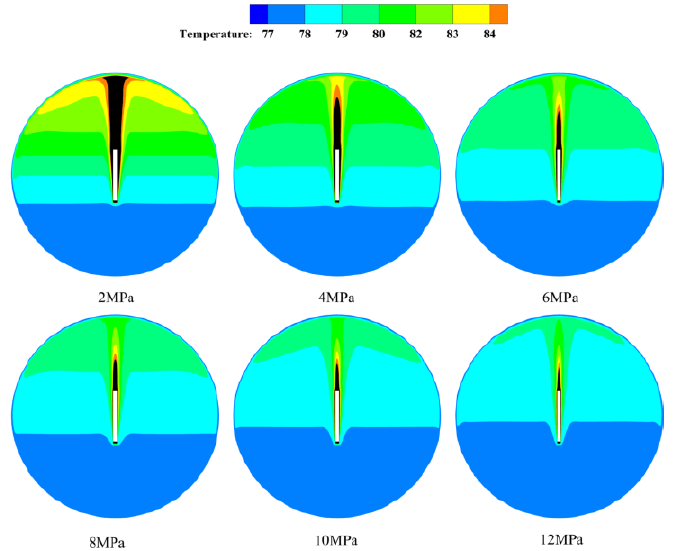
Figure 8. Temperature distribution of the supercritical helium under different conditions (heating power: 100 W, temperature range: 77–85 K).